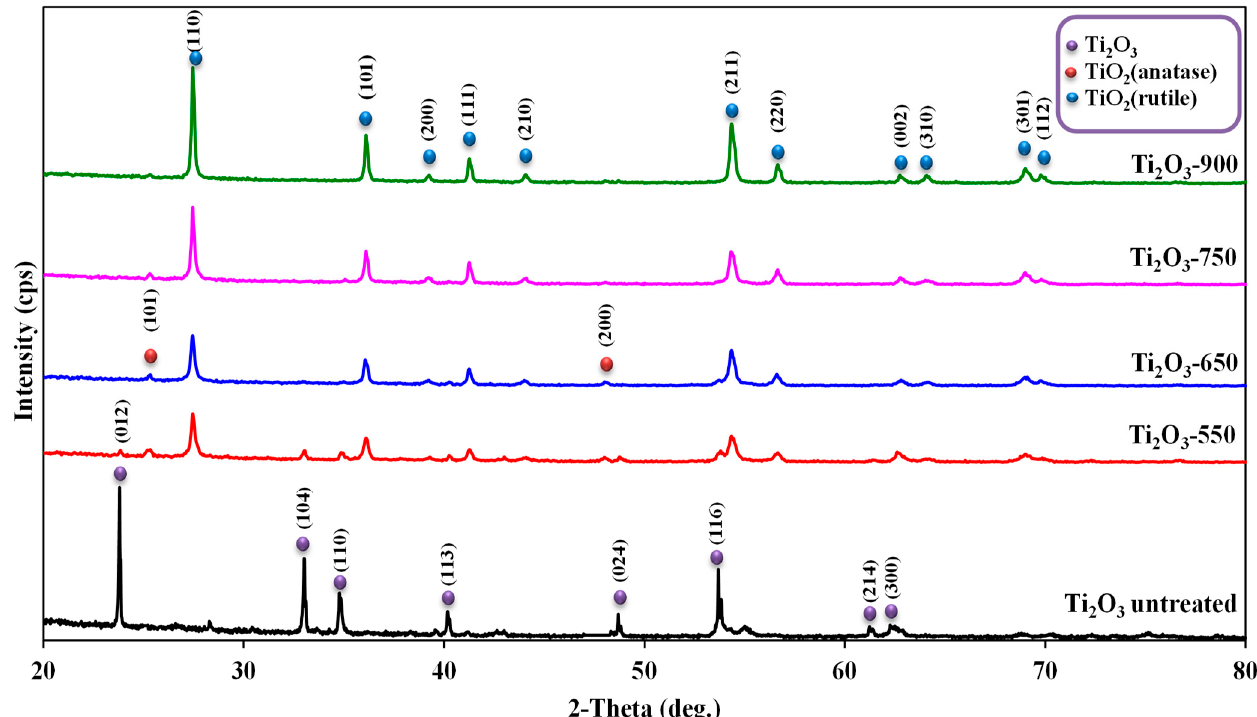
Figure 2. XRD patterns of treated Ti 2 O 3 catalysts.